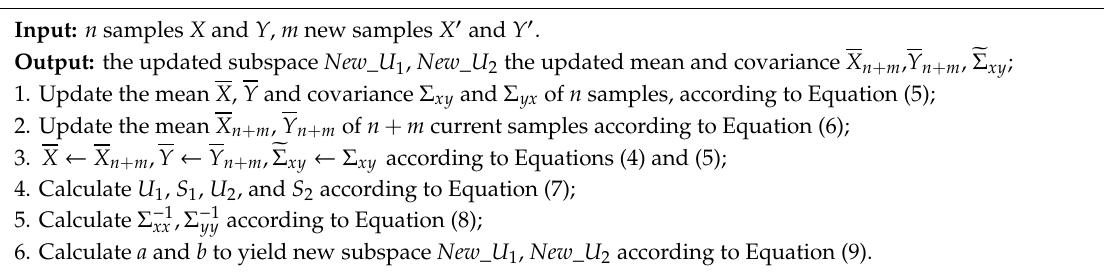
Algorithm 1. Incremental Subspace